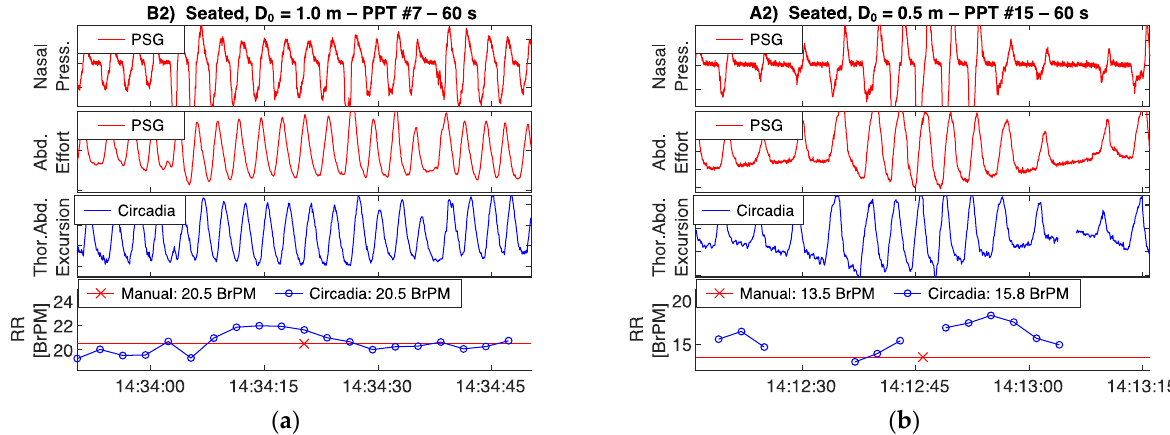
Sensors 2021 , 21 , x FOR PEER REVIEW Figure 5. Circadia respiratory thoracoabdominal excursion (blue), and reference nasal pressure and abdominal effort (red) for two example epochs from Study 1. Circadia continuous respiratory rate (RR; blue) and manually scored RR based on reference data (red) are shown in the bottom graph, with final RR values of both methods in the legend of the bottom graph.